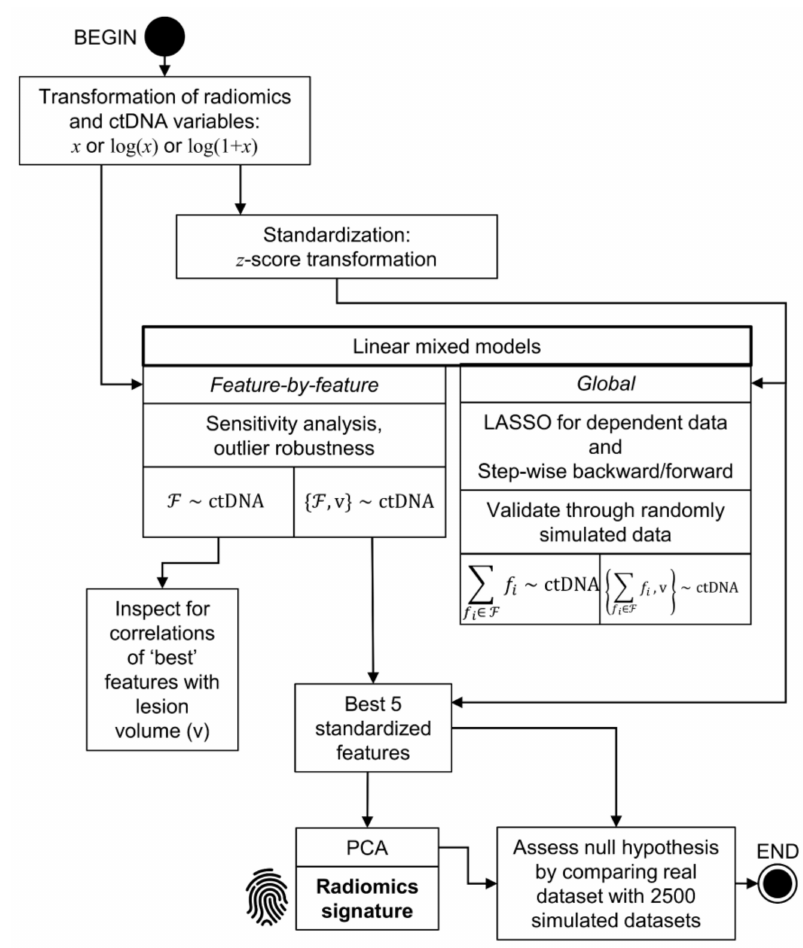
Figure 2. Flow-chart illustrating the detailed statistical analysis methods. The radiomic feature variables and the ctDNA maf response variable were both transformed for optimal statistical